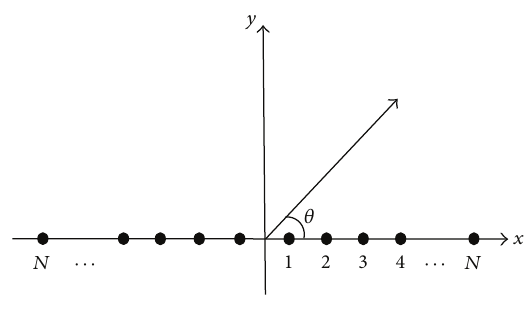
Figure 1: Antenna array